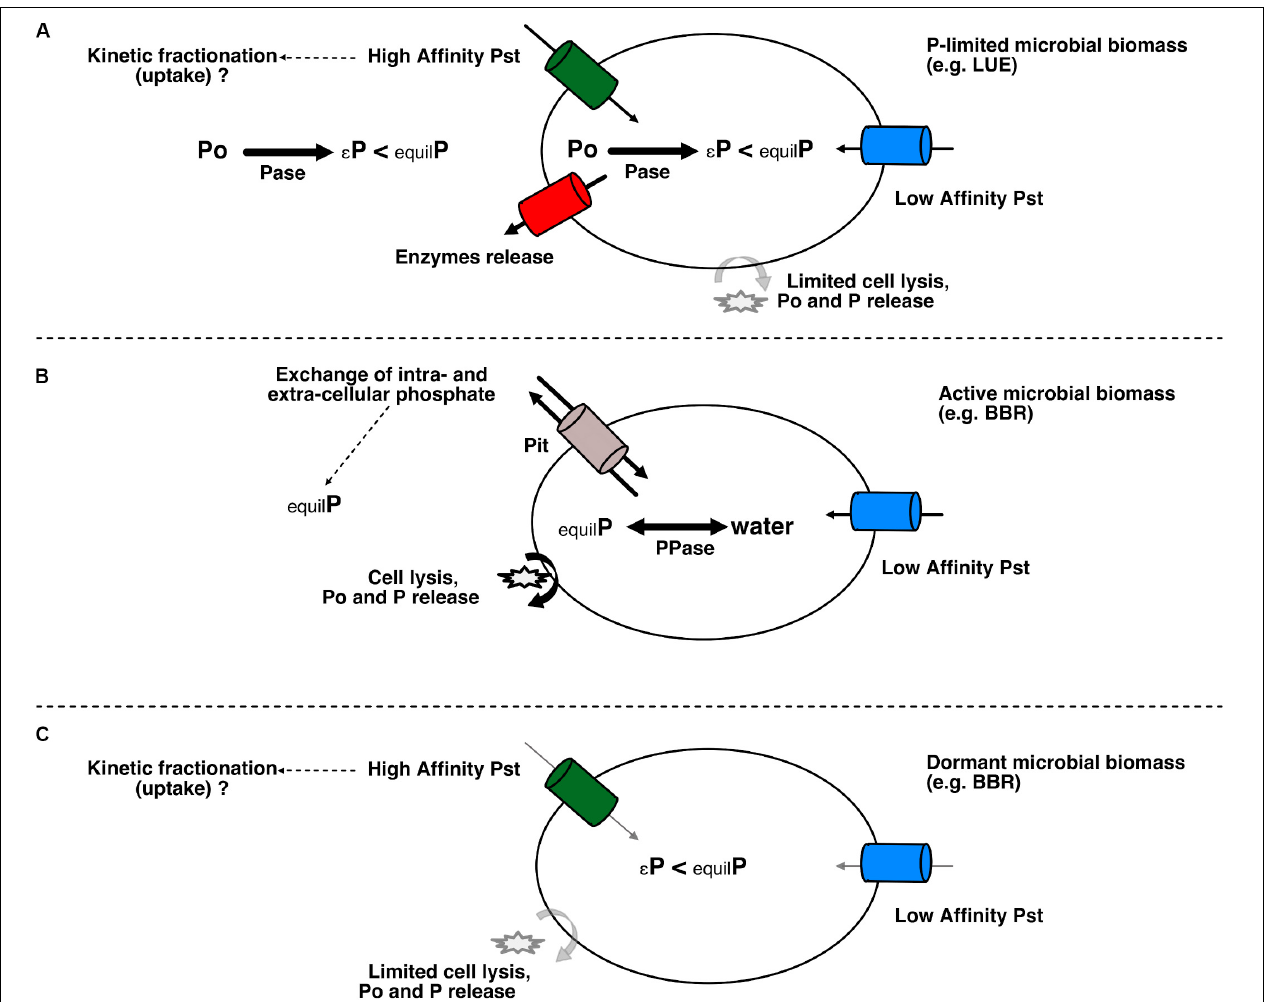
FIGURE 5 | Schematic representation of microbial processes under active stressed or dormant status and their effect on δ 18 O-P res and δ 18 O-P mic adapted with permission from Lis et al. (2019). Copyright (2019) American Chemical Society. (A) Case of microbes under low P conditions [e.g., Lüss (LUE) soil]. Intracellular P is not at isotopic equilibrium, since inorganic pyrophosphatase (PPase) is not dominant and other enzymes, e.g., phosphomonoesterase, are controlling the δ 18 O-P mic . Only influx of phosphate ions is observed through phosphate specific transporters (high and low affinity Pst) and cell lysis might be limited. Phosphatase enzymes are actively excreted by the cells to hydrolyse Po compounds. These enzymatic reactions imprint an isotopic kinetic effect on the δ 18 O-P res . (B) Case of microbes not limited by any environmental factor [e.g., active microbes in Bad Brückenau (BBR) soils]. Oxygen in intracellular phosphate is equilibrated with oxygen in water via the action of PPase. Intracellular phosphate is leaked out to the soil environment by either the low affinity Pit transporter or cell lysis (see Lis et al., 2019). δ 18 O-P res is controlled by the intracellular P and exhibits an equilibrium signature. (C) Case of microbes in a dormant state (limited by factors other than P availability, such as in BBR soils): uptake from the soil solution is limited and intracellular processes (e.g., phosphatases catalyzed reactions or other processes guaranteeing the minimal functioning of the cell; see Blagodatskaya and Kuzyakov (2013)] are imprinting an isotopic kinetic effect on δ 18 O-P mic . This portion of the microbial biomass have little impact on the P res . EquilP, phosphate with oxygen at equilibrium with oxygen in water; ε P, phosphate released from hydrolysis of Po with a kinetic isotope